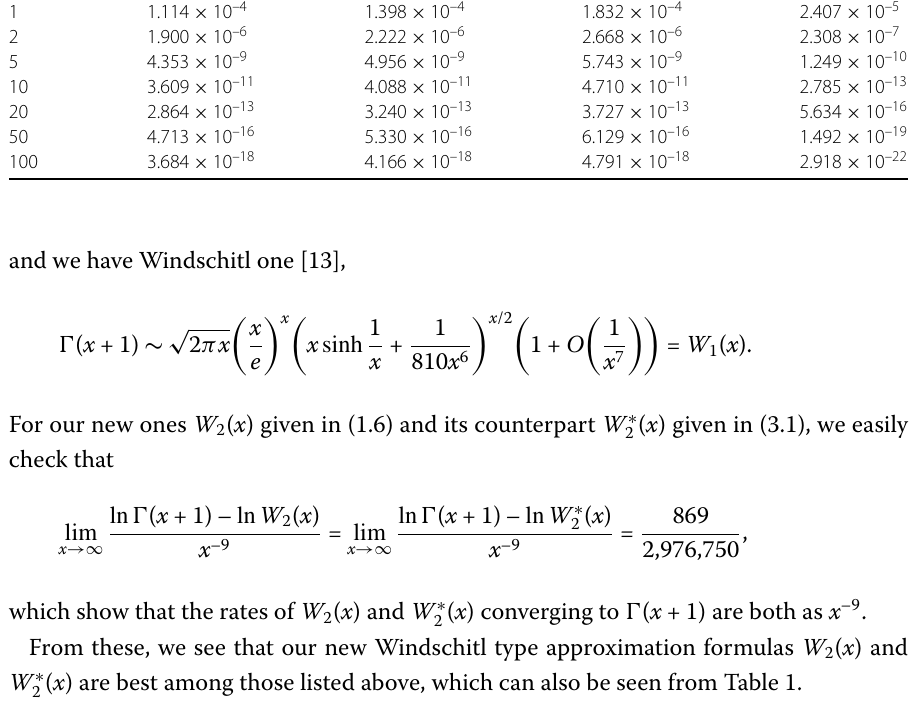
Table 1 Comparison among N 2 (4.2), C (4.1), W 1 (1.3) and W 2 (1.6)